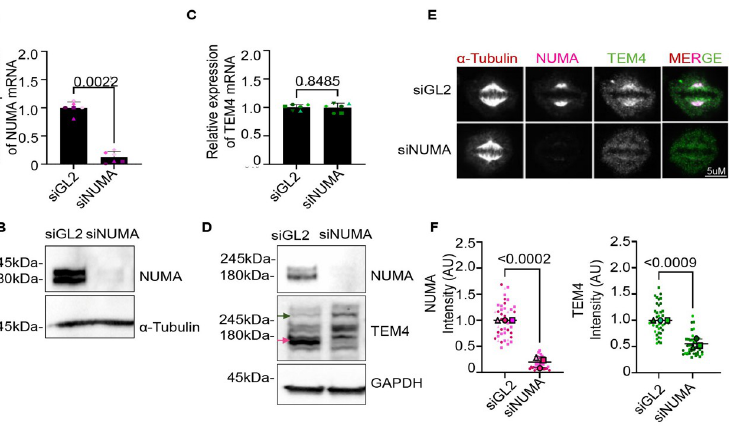
Fig 6. TEM4 microtubule staining is lost upon NuMA depletion without any alteration on the mRNA expression levels of TEM4. A: NuMA gene expression levels on HeLa-T-REx cells transfected for 72h with 120 nM of GL2 or NuMA siRNA. Levels of NuMA mRNA were measured by RT-qPCR in 5 independent biological replicates. Gene expression of targeted mRNA was normalized to two reference genes, GAPDH and HPRT-1. B: Cells were treated as in A. 72 hours post transfection total cells lysates were collected and total proteins were extracted with RIPA buffer. Lysates were subjected to Western Blot analysis and stained with α -tubulin as a loading control and NuMA. C: TEM4 gene expression levels in HeLa-T-REx cells transfected with scrambled or NuMA siRNA for 72 hours. Levels of TEM4 mRNA were measured by RT-qPCR in 6 independent biological replicates. Gene expression of targeted mRNA was normalized to two reference genes, GAPDH and HPRT-1. D: Cells were treated as in C. 72 hours post transfection total cells lysates were collected and total proteins were extracted with RIPA buffer. Lysates were subjected to Western Blot analysis and immunoblotted with the indicated antibodies. E: Immunofluorescence images of HeLa-T-REx cells transfected with GL2 or NuMA siRNA for 72 hours as previously. Cells were synchronized in mitosis after 10 hours of release from double thymidine block and fixed for 10 minutes with PTEMF buffer. Fixed cells were stained with anti- TEM4 (green), anti- α -tubulin for the spindle microtubules (red) anti-NuMA (pink). Scale bar = 5 μ m. F: Quantification analysis of TEM4 and NuMA intensity at the mitotic spindle corresponding to 6E. A minimum of 15 cells per condition per experiment was counted and the graphs show superplots from 3 independent experiments. The P value is calculated from unpaired